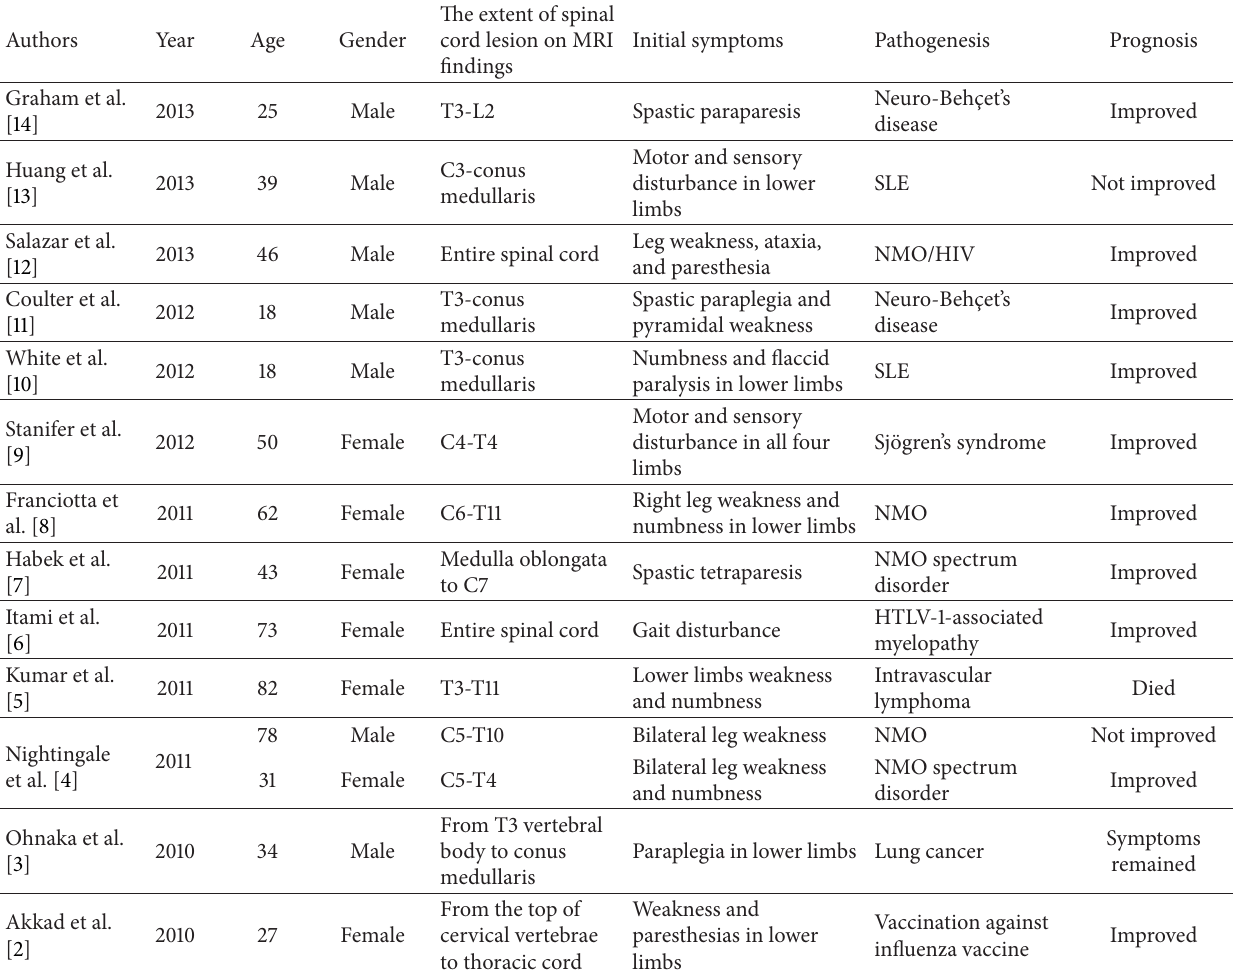
Table 1: Clinical features of LETM reported previously within 3